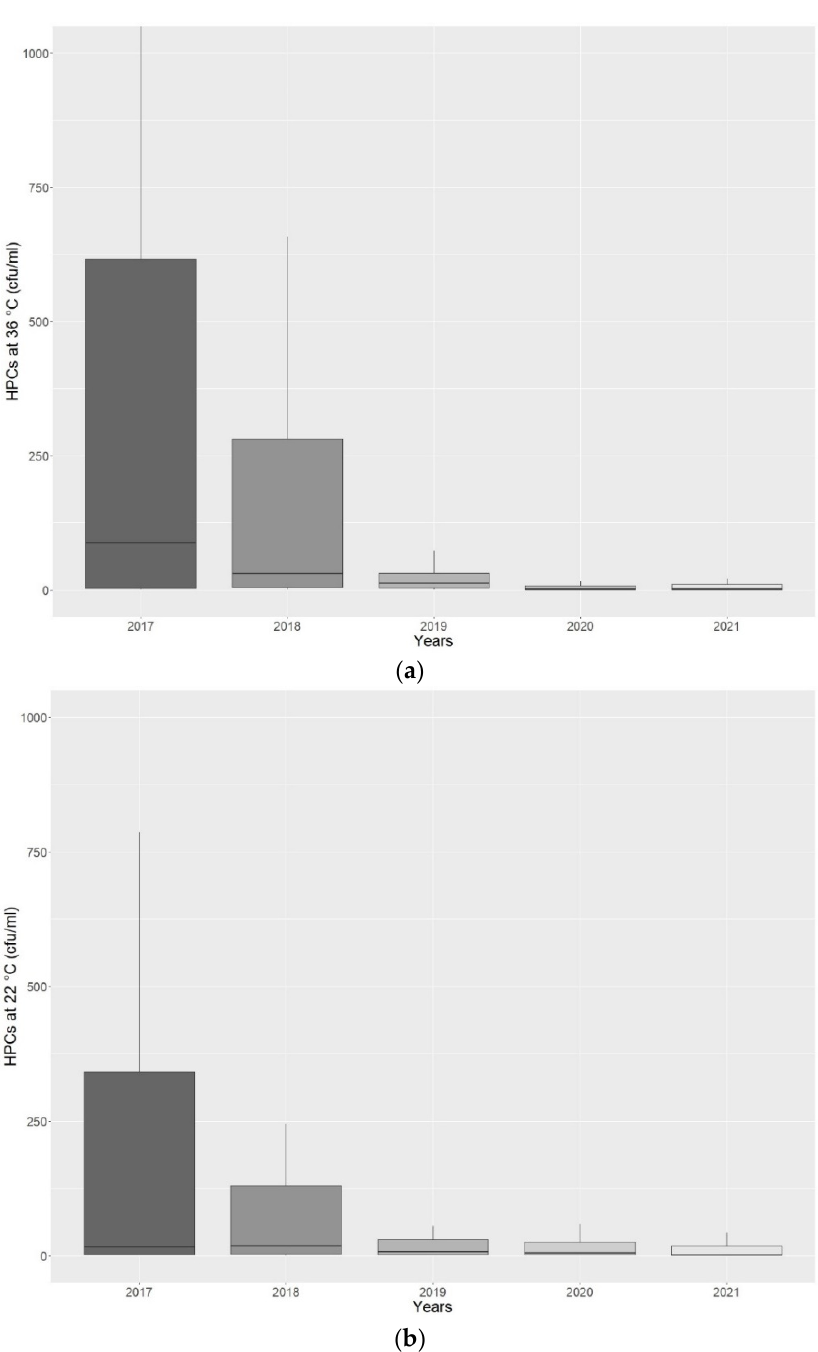
Figure 4. ( a ) Boxplot graph showing a decreasing trend for heterotrophic plate counts (HPCs) at 36 ◦ C observed during the period of analysis, from 2017 to 2021. Outliers are not displayed. ( b ) Boxplot graph showing a decreasing trend for heterotrophic plate counts (HPCs) at 22 ◦ C observed during the period of analysis, from 2017 to 2021. Outliers are not